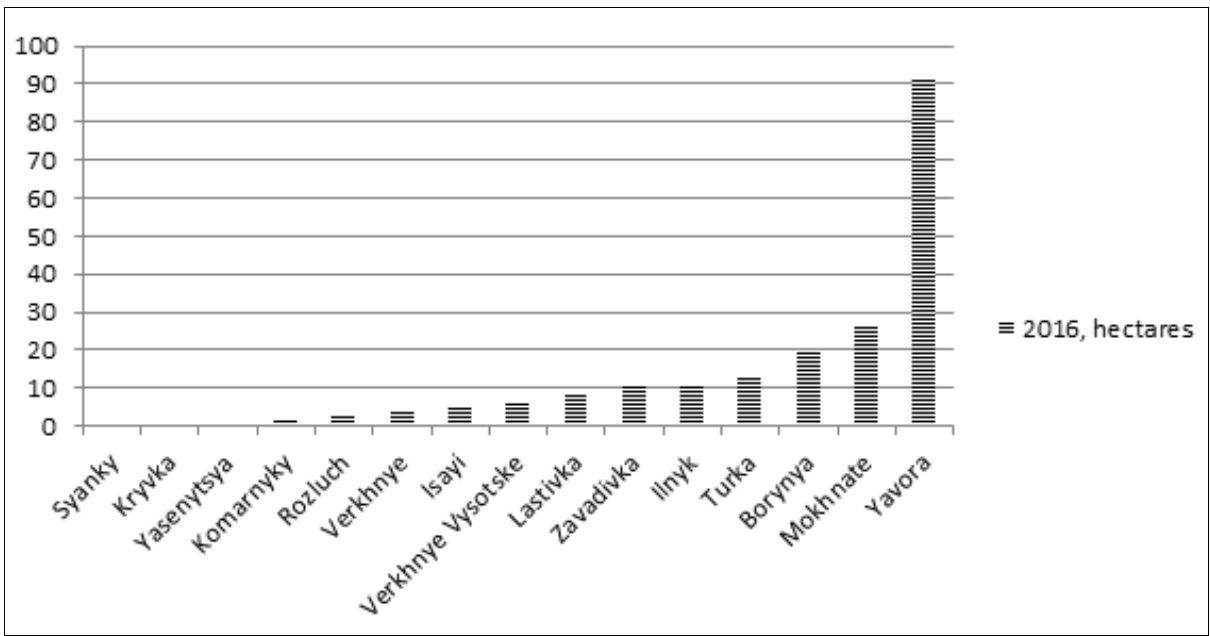
Fig. 1. Areas occupied by H. sosnovskyi in Turka district (Conducting measures for the protection…,